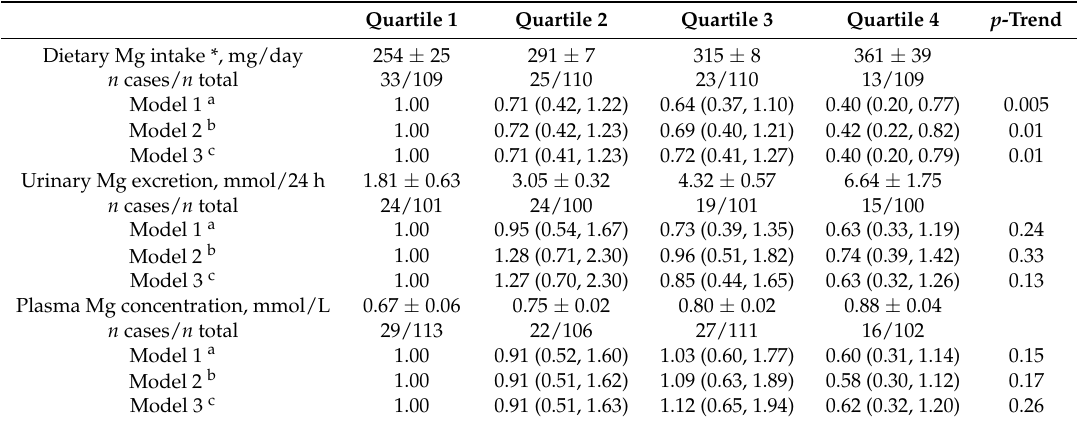
Table 2. Prevalence ratios (95% CI) for associations between dietary, urinary and plasma Magnesium and coronary heart disease in type 2 diabetes from the DIAbetes and LifEstyle Cohort Twente (DIALECT) ( n = 450). Quartile 1 Quartile 2 Quartile 3 Quartile 4 p -Trend 254 ± 25 291 ±